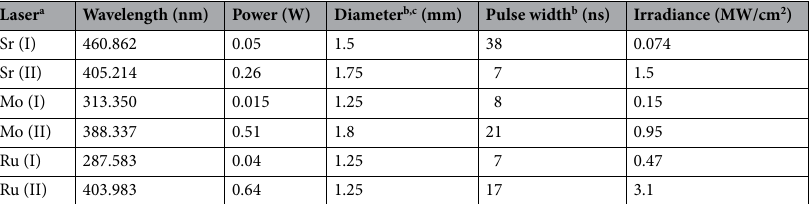
Table 1. RIS laser parameters. a The pulse repetition rate for all lasers was 1 kHz. Roman numerals refer to the step in the ionization process. b Full width at half maximum. c Average of major and minor axes; ellipticities ranged from 1.0 to 1.3.